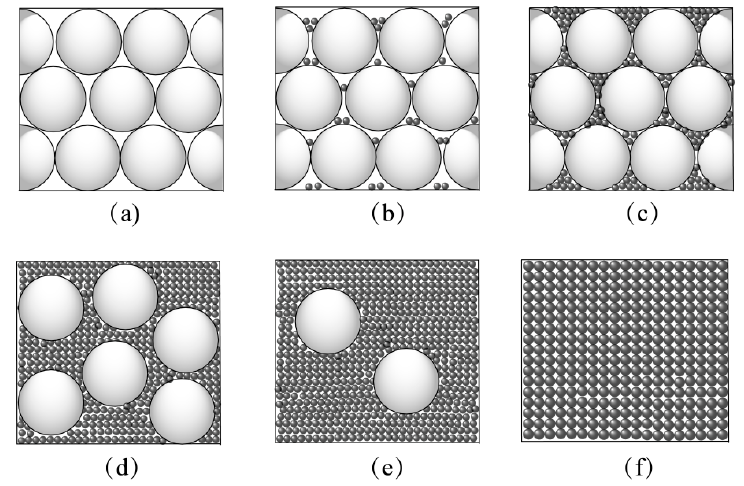
Figure 9. Illustration of the mixture of coarse-grained and fine-grained particles.